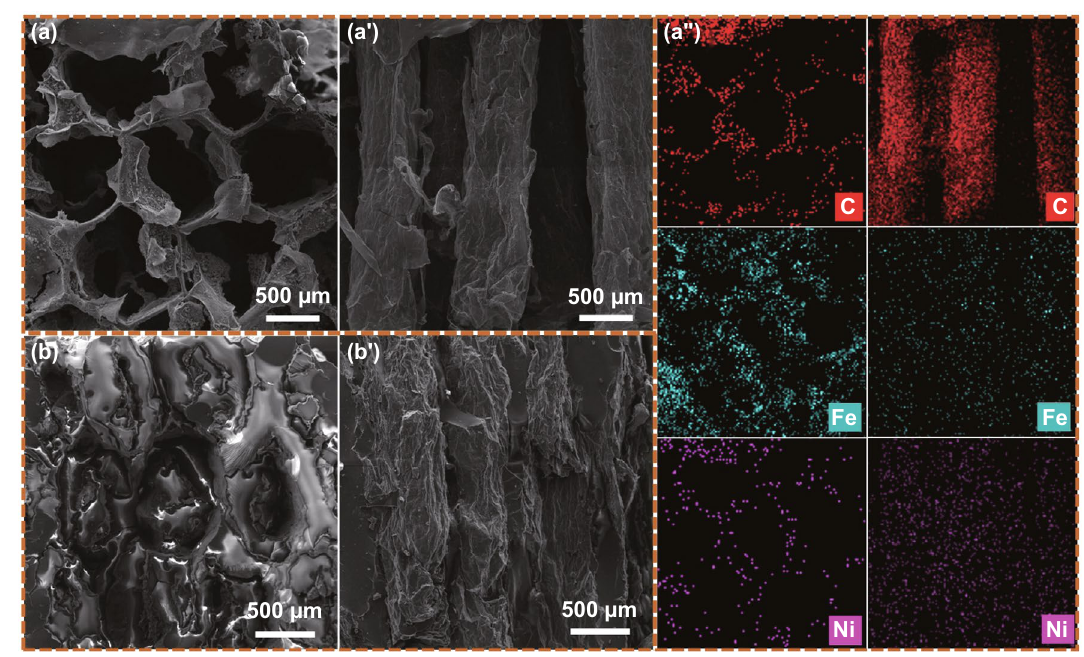
Fig. 3 SEM images of rGH@FeNi aerogel (rGH 1.2 wt%, f -FeNi 0.9 wt%) along the cross and longitudinal sections ( a & a ′ ), elemental map- ping images of C, Fe and Ni for rGH@FeNi aerogel ( a ′′ ), SEM images of rGH@FeNi/epoxy composites (rGH 1.2 wt%, f -FeNi 0.9 wt%) along the cross and longitudinal sections ( b & b ′